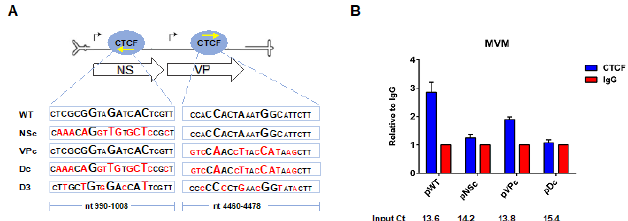
Figure 2. CTCF binding to the single DNA-binding site mutants is reduced, while it is almost completely abolished on the double mutant ( A ) schematic representation of MVM genome showing the positions of transcriptional promoters (solid black arrows), the major open reading frames (arrowed boxes), the relative positions of CTCF binding sites (blue oval shapes) and the nucleotide sequences of the WT and the mutant CTCF binding sites in the NS and VP region. The nucleotides that were mutated within the CTCF binding motifs are shown in red. The yellow arrows show the orientation of the CTCF motifs on the viral genome. ( B ) Human NB324K cells were transfected with the WT or the indicated CTCF-binding site mutants, and harvested at 20 hpt as described in Materials and Methods for whole-cell lysate ChIP using antibodies directed against the cellular factor CTCF or the mouse IgG protein. Samples were analyzed by qPCR as described in Materials and Methods and presented relative to IgG isotype control. Data are presented as mean ± SEM of two individual experiments. Ct values (average of the two experiments) for each plasmid transfection are shown and indicate similar levels of target DNA in the samples.